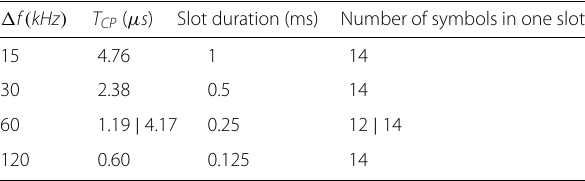
Table 1 Numerology structures for data channels in